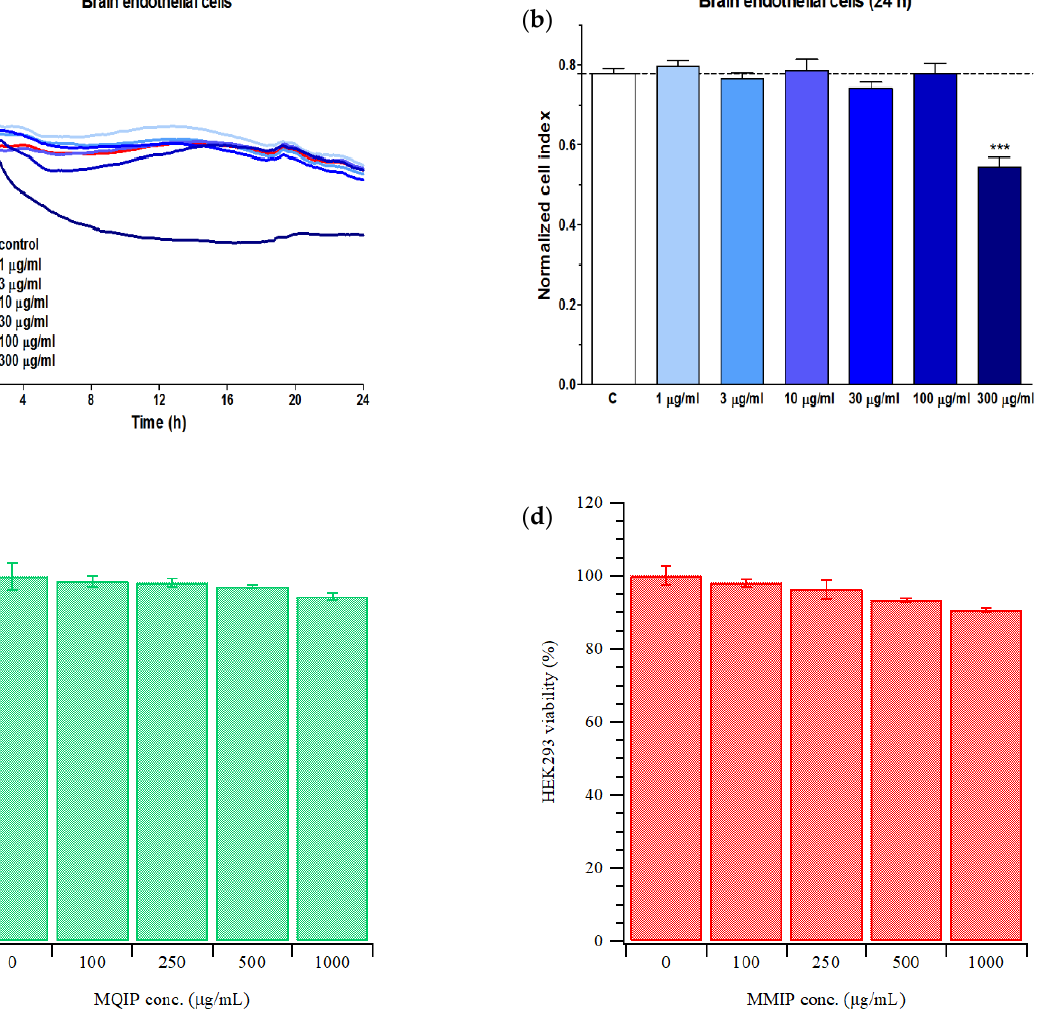
Figure 5. The effect of different concentrations of MMIPs on the ( a ) cell viability kinetics and ( b ) cell viability at 24-h time points of endothelial cells. Cultured primary endothelial cells were treated with various concentrations of MMIPs (1 µ M to 300 µ M) for 24 h. Control group received culture medium. Mean ± SD, n = 4–12, ANOVA, Dunnett’s multiple comparison test, *** p < 0.001 compared to the control group. Cytotoxicity of various concentrations of ( c ) magnetic CRISPR/Cas9 peptide- imprinted polymers (MQIPs) and ( d ) magnetic SNCA peptide-imprinted polymers (MMIPs) on HEK293T